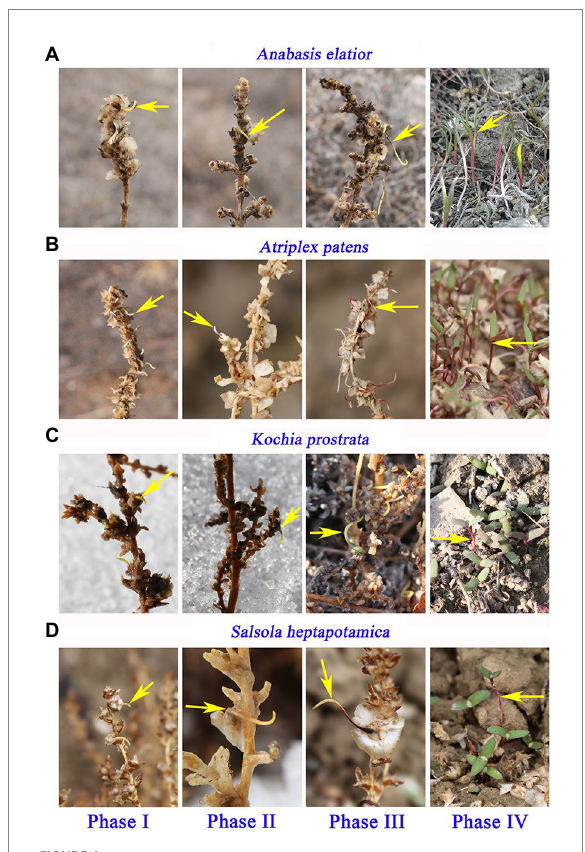
FIGURE 4 The development of seedlings from pre-dispersal germinated seeds for four Amaranthaceae species [ (A) Anabasis elatior (top row), (B) Atriplex patens (second row), (C) Kochia prostrata (third row), and (D) Salsola heptapotamica (bottom row)] in the cold deserts of northern Xinjiang. Phase I, radicle initially emerged from the bracteoles; Phase II, radicle completely emerged and hypocotyl emerged from the bracteoles; Phase III, cotyledons mostly emerged through the bracteoles; and Phase IV, seedlings dispersed to the soil